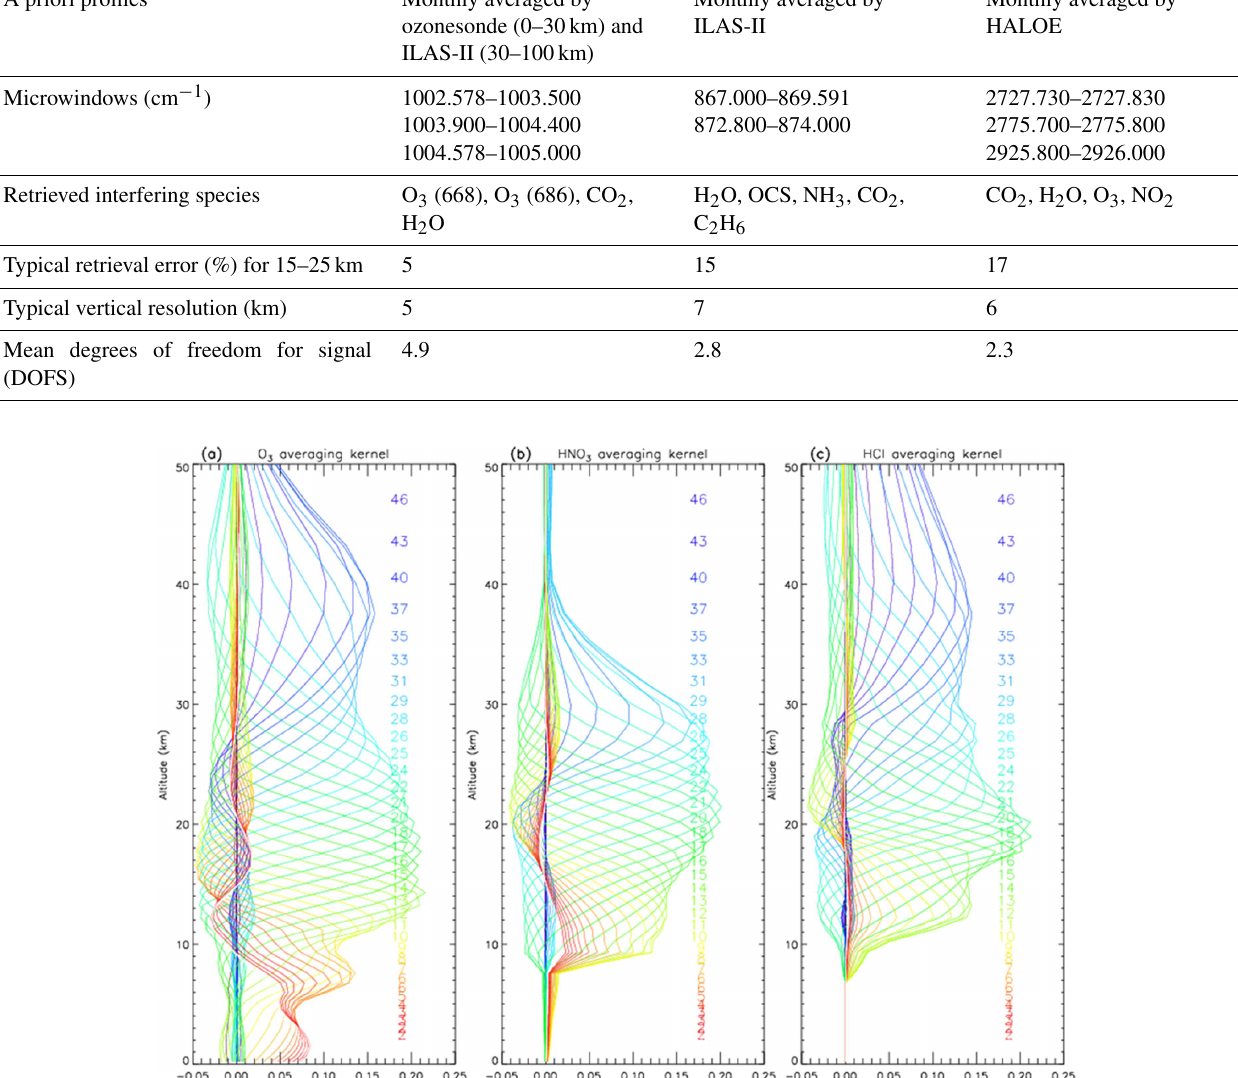
Figure 1. Averaging kernel functions of the SFIT2 retrievals for (a) O 3 , (b) HNO 3 , and (c) HCl.